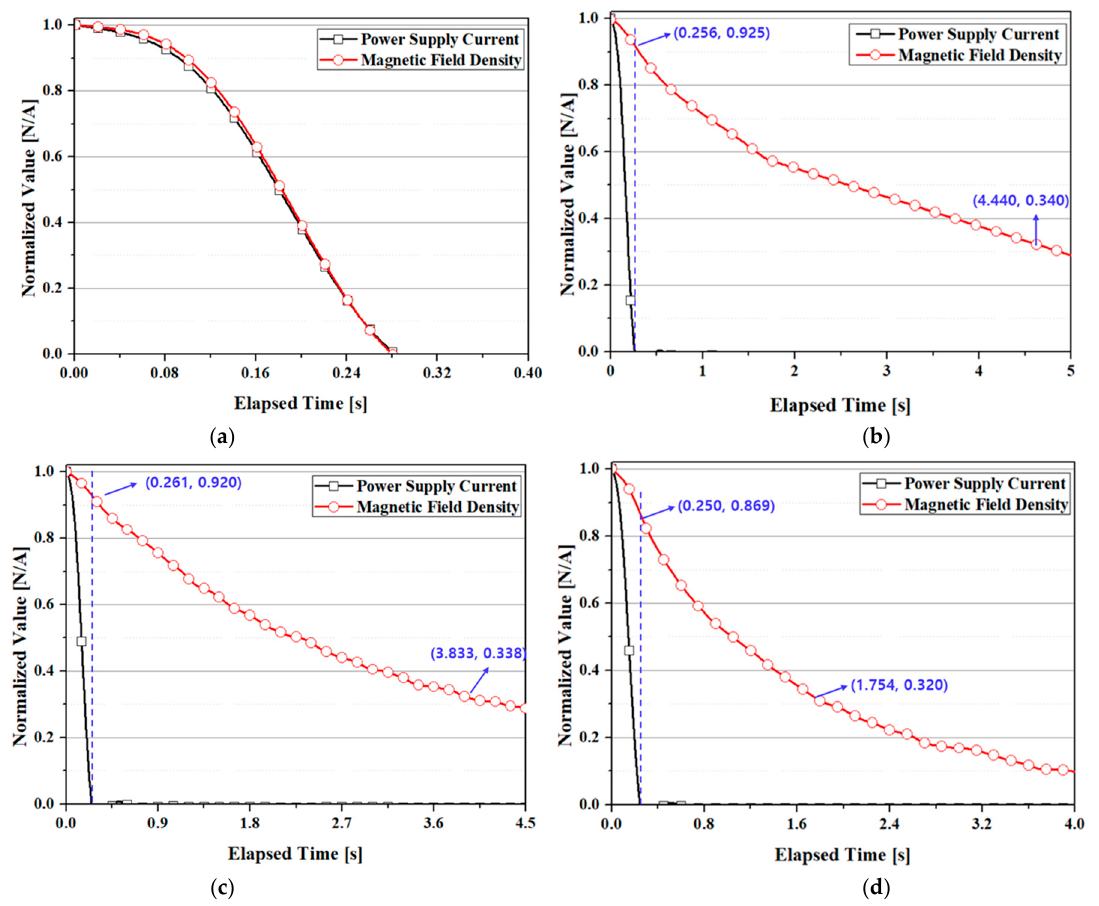
Figure 4. Sudden discharging test results: ( a ) Coil I, ( b ) Coil II, ( c ) Coil III, and ( d ) Coil IV.